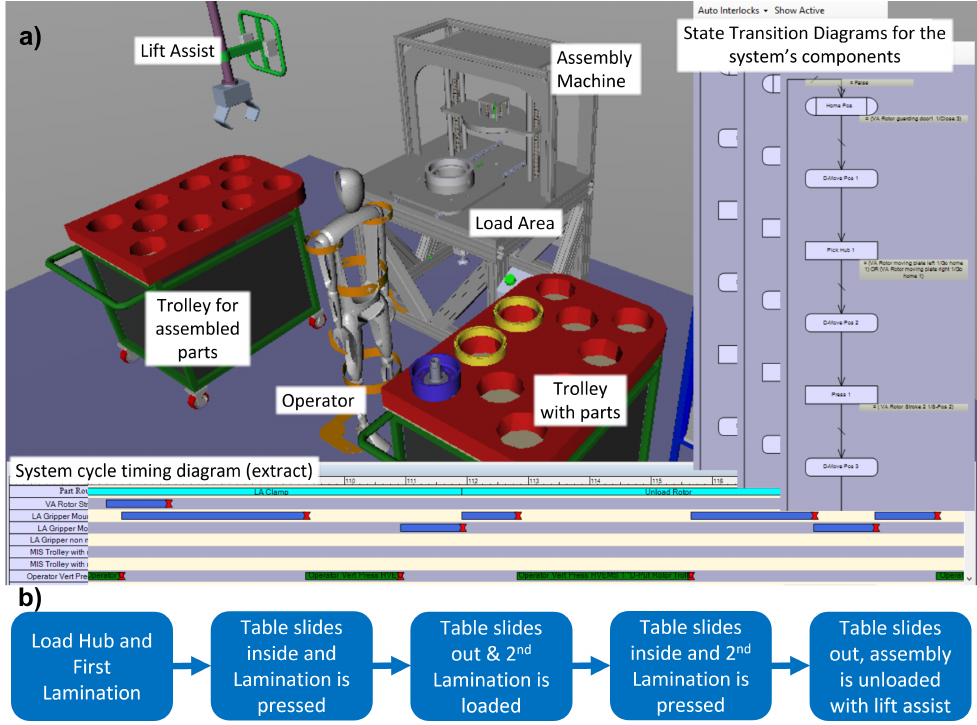
Figure 4. ( a ) Initial design of the vertical assembly station ( b ) The sequence of the process